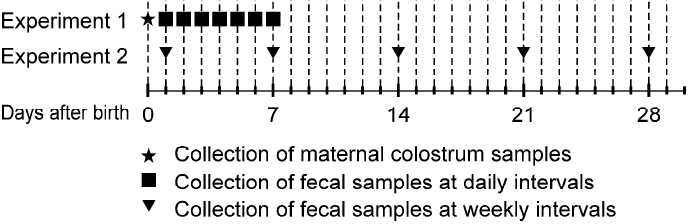
Figure 1. Sampling scheme for experiments 1 and 2. Neonatal dairy calves were sampled once a day for 7 days ( n = 10) or once a week for 28 days ( n = 19), and maternal colostrum samples ( n = 6) from corresponding dams were obtained.